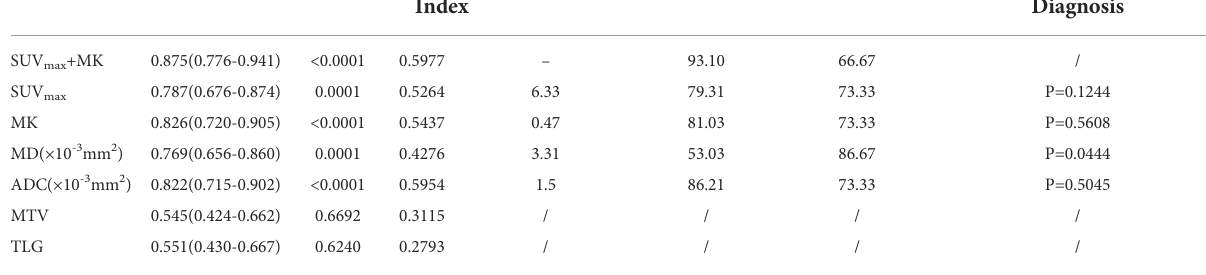
TABLE 4 Sensitivity and speci fi city of diffusion parameters at optimal cutoff values in differentiating malignant from benign solitary pulmonary lesions.